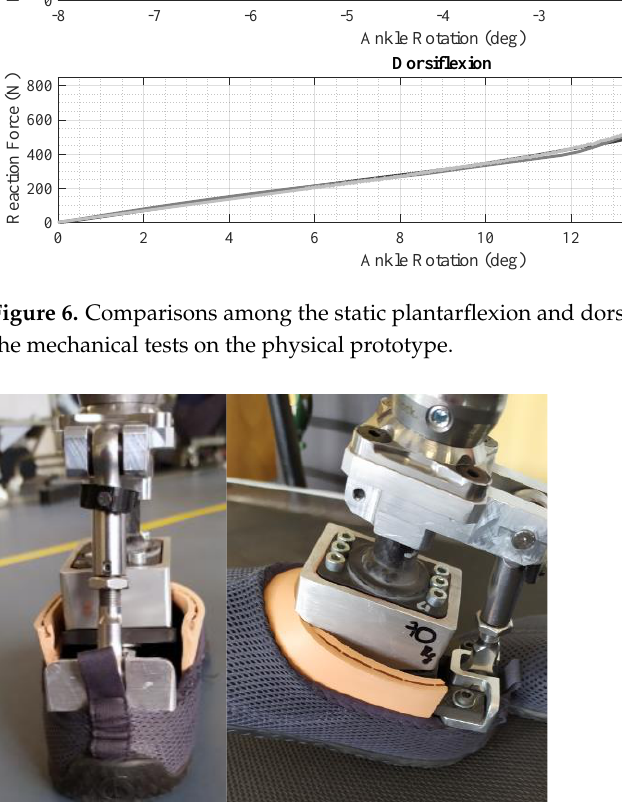
Figure 7. The interference between the middle blade and the foot shell (not designed for MyFlex- δ